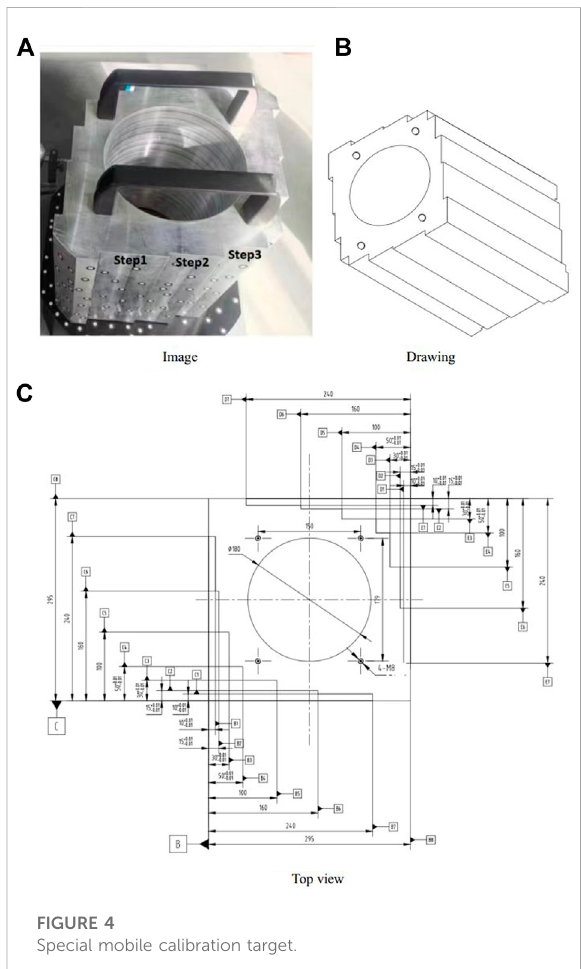
FIGURE 4 Special mobile calibration